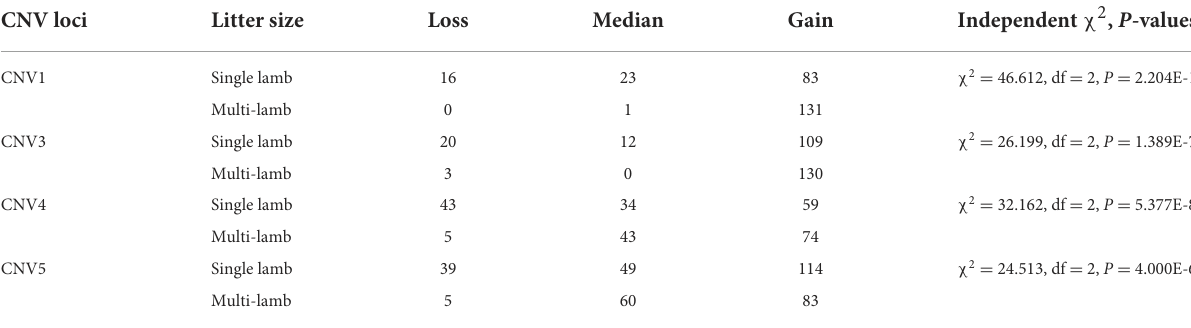
TABLE 6 The distribution of different CNVs between mothers of single-lamb and multi-lamb population. CNV